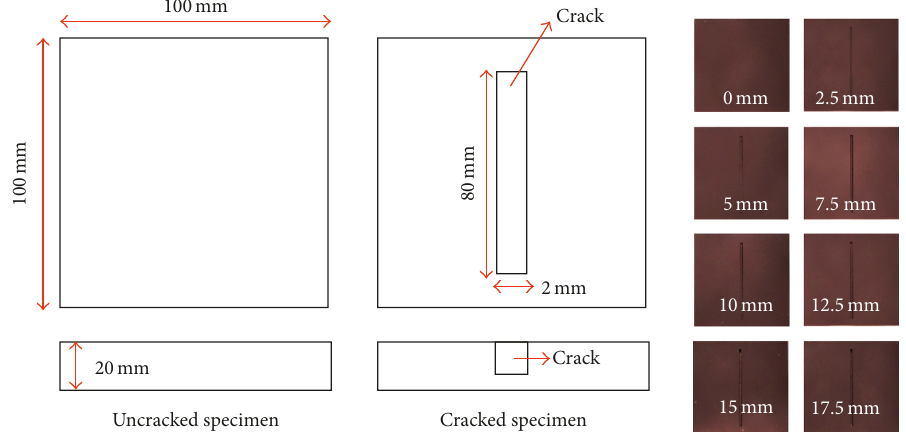
Figure 2: Dimension of test specimens painted with black matte spray.